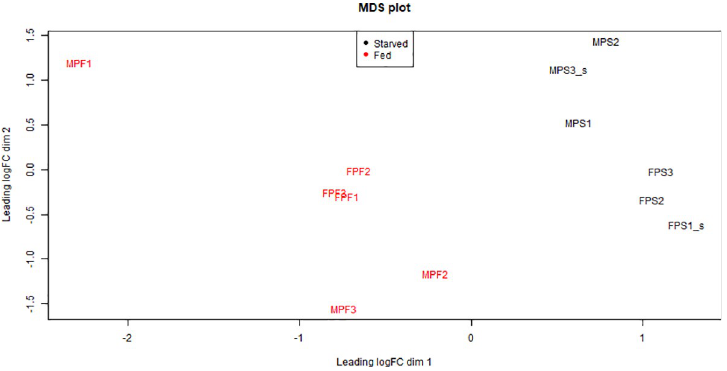
Fig 3. Multi-dimensional scaling (MDS) plot of the normalized read counts. Samples cluster together based on whether they came from a fed or starved beetle.